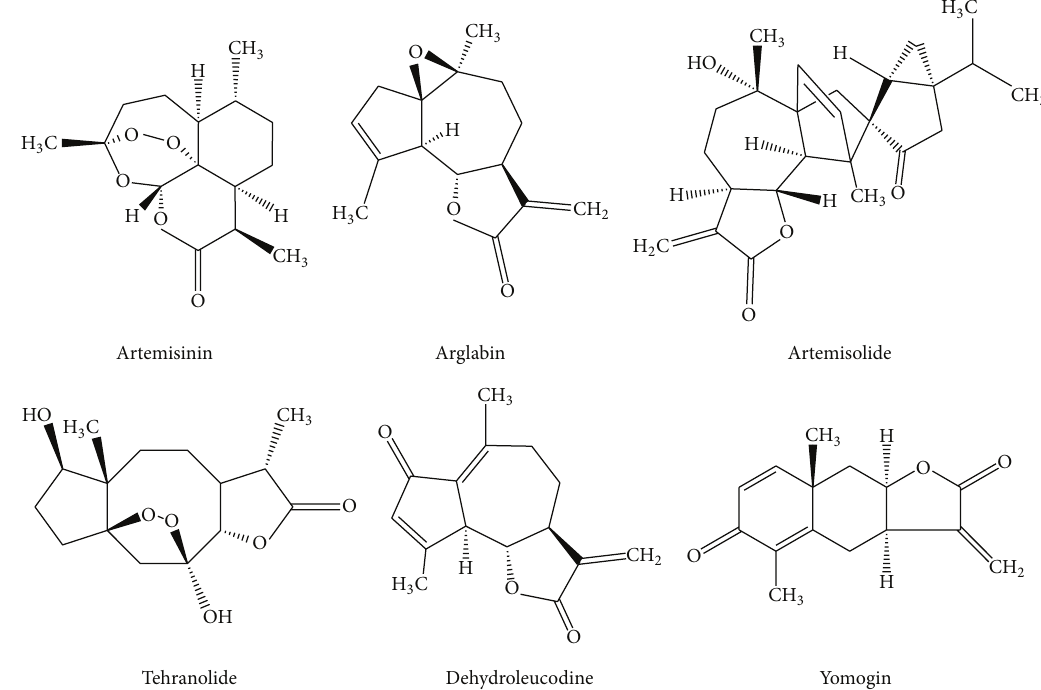
Figure 1: Structures of bioactive sesquiterpene lactones from Artemisia